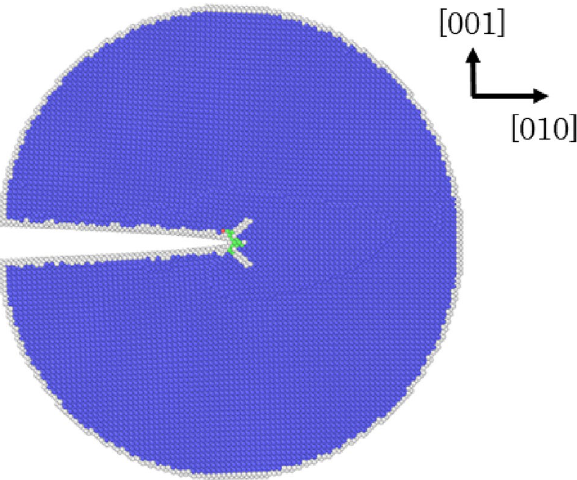
Figure 1. A numerical simulation of a straight crack front using an EAM potential 29 shows typical artifacts, i.e. fictional plastic deformation at the crack tip. Coloring is based on common neighbor analysis; blue, green and white parts indicate bcc, fcc, and other crystals, respectively. Although the displacement field is not large enough for crack propagation, partial slips are observed along {110} planes in the vicinity of the crack tip, and an fcc crystal part appears as